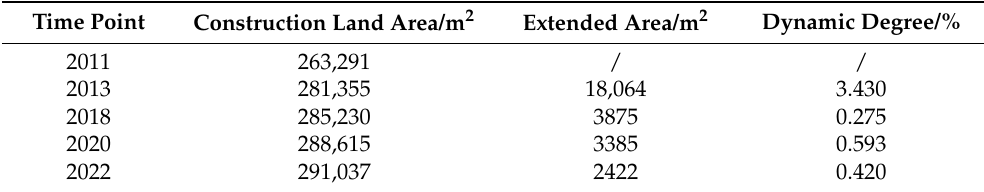
Table 1. The changes in construction land in Lingquan Village at different time points.